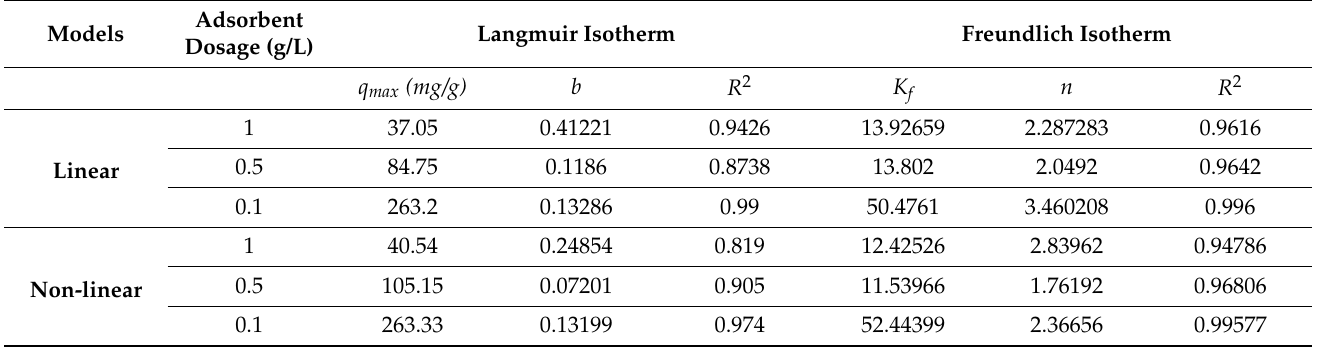
Figure 8. Nonlinear models of Langmuir adsorption isotherm at dosages ( a ) 0.1 g/L, ( b ) 0.5 g/L, ( c ) 1.0 g/L and Freundlich adsorption isotherm at ( d ) 0.1 g/L, ( e ) 0.5 g/L, ( f ) 1.0 g/L.